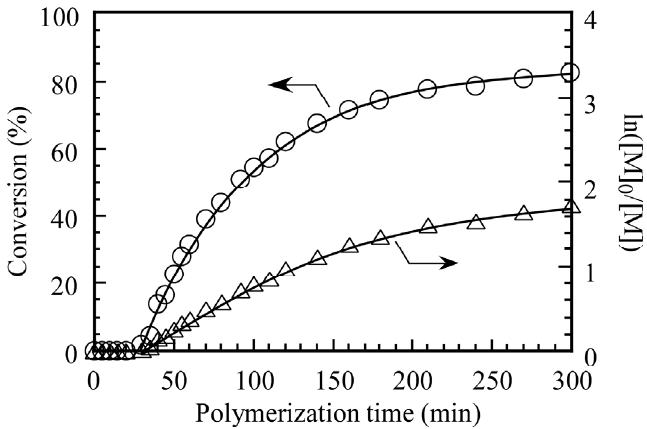
Figure 2. Time–conversion ( ○ ) and the first-order kinetic plots ( △ ) for polymerization of DEA in the presence of PMPC ( M (NMR) = 1.89 × 10 4 , M 64 n 70 °C. [M] and [M] are the concentrations of the monomer at polymerization time = 0 and 0 the corresponding time, respectively.